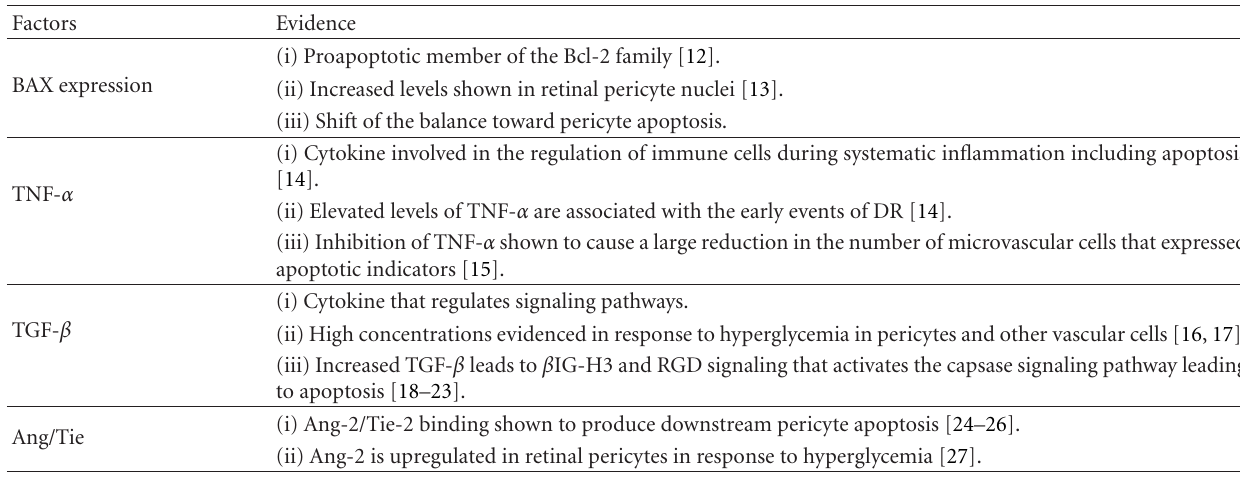
Table 1: Possible causes of pericyte